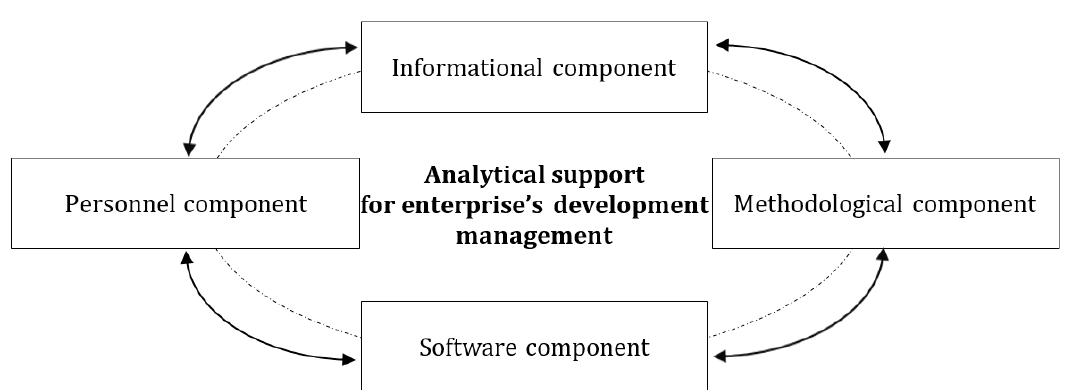
Figure 1: Structure of the analytical support for enterprise’s development management